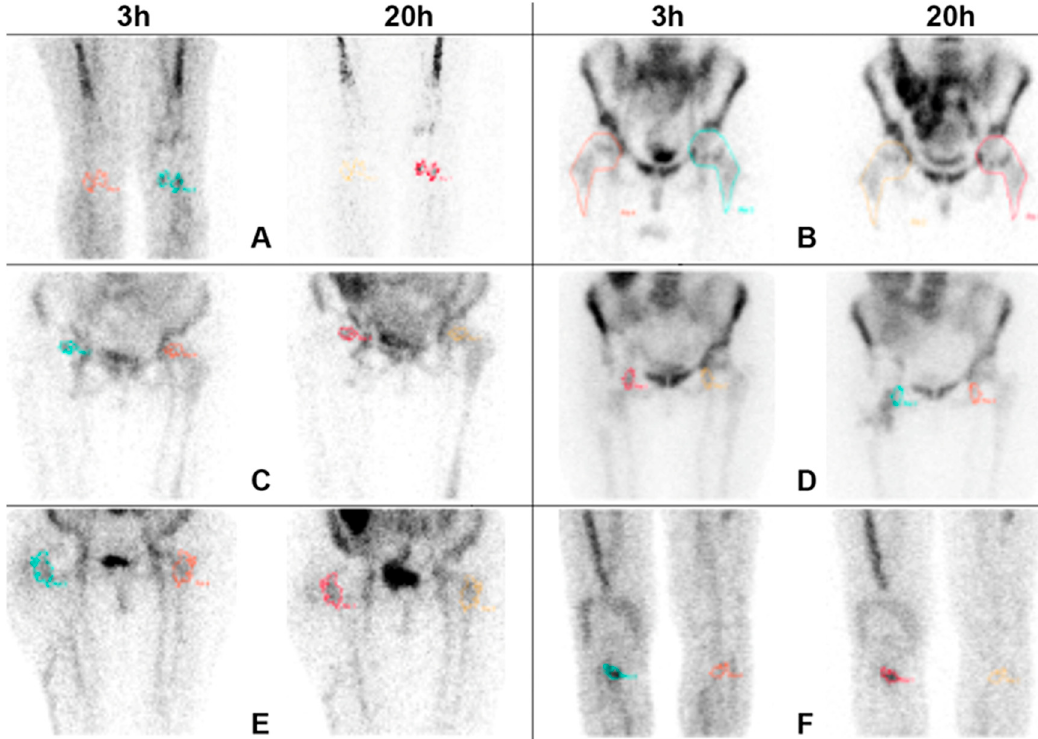
Figure 1. Anterior views acquired 3 h and 20 h after i.v. injection of radiolabelled leukocytes, with times corrected for isotope decay and displayed by using absolute counts and the same intensity colour scale. Images show an example of the methodology used for drawing regions of interests (ROIs) for all the criteria ( A – F ). In all doubtful cases, except for criterion B, irregular ROIs were automatically drawn on the target (T) of late images by fixing a threshold of 40% of maximum pixel, mirrored on the contralateral background (B) and copied on T and B of delayed images. For criterion B, due to the presence of bone marrow interference on the evaluation of the suspected area, ROIs were manually drawn on the whole